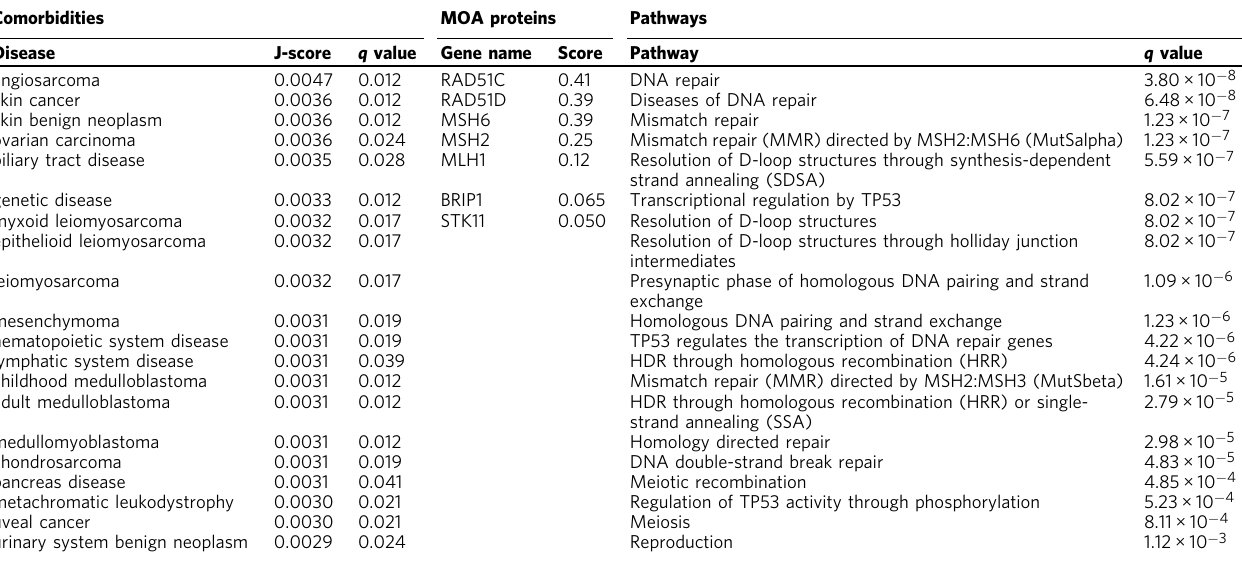
Table 5 Top 20 comorbidities, seven comorbidity enriched MOA proteins (with respect to input), and top 20 pathways associated with the prediction OC GWAS-driven results using the gene set from ref. 52